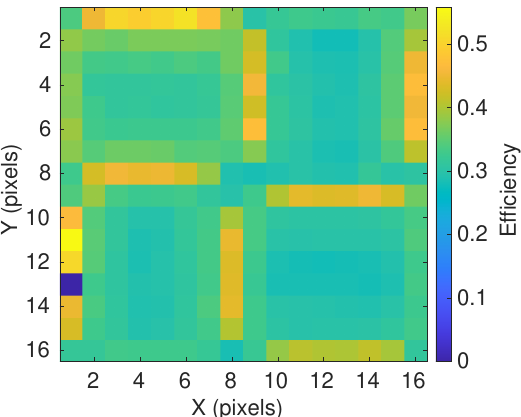
Figure 9. Efficiency map for one EC unit. Colors denote estimated photon detection efficiency of individual pixels in fractions of 1, which corresponds to 100%